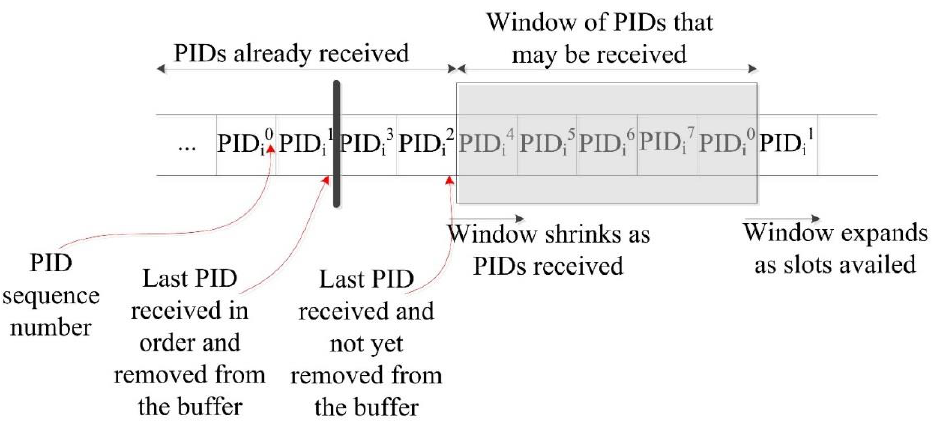
Figure 7. Sliding window for received PIDs